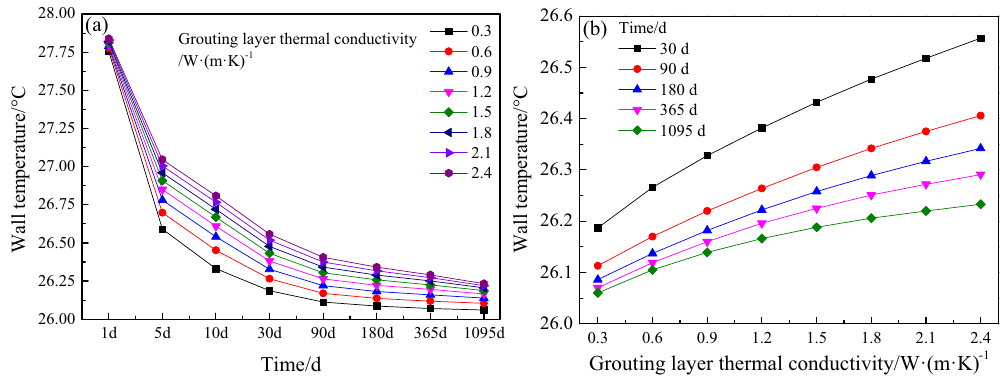
Figure 11: Influence of grouting layer thermal conductivity on wall temperature: ( a ) wall temperature change with time; ( b ) wall temperature change with grouting layer thermal